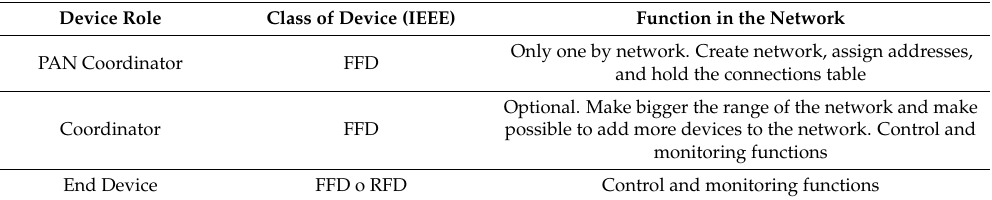
Table 2. Devices role (IEEE 802.15.4).